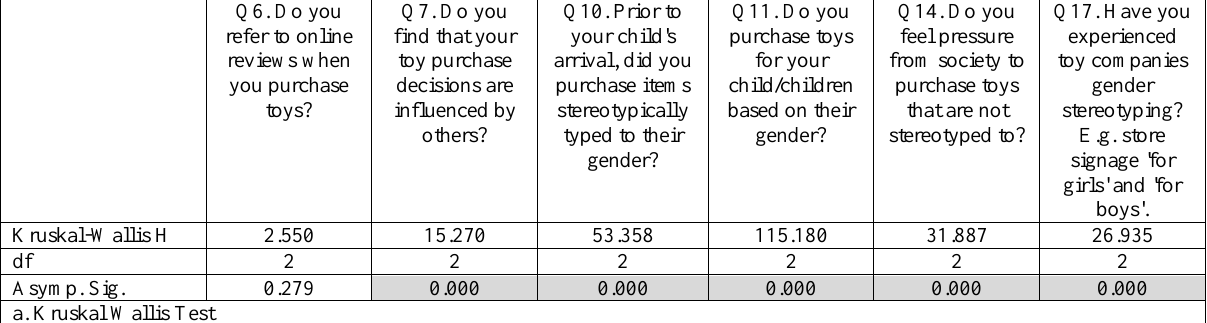
Table 5. Kruskal–Wallis test depending on perceptions of gender-neutral